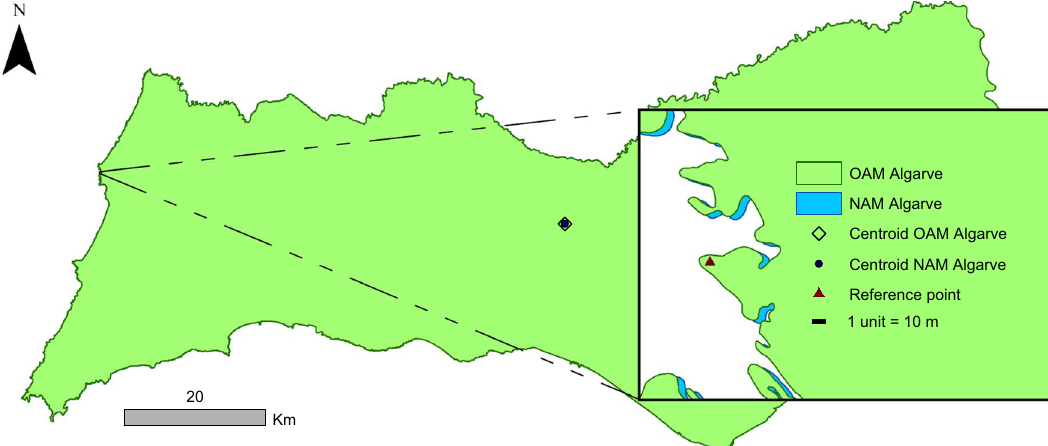
Figure 3. Distinctions between OAM Algarve (green) and NAM Algarve (blue) for